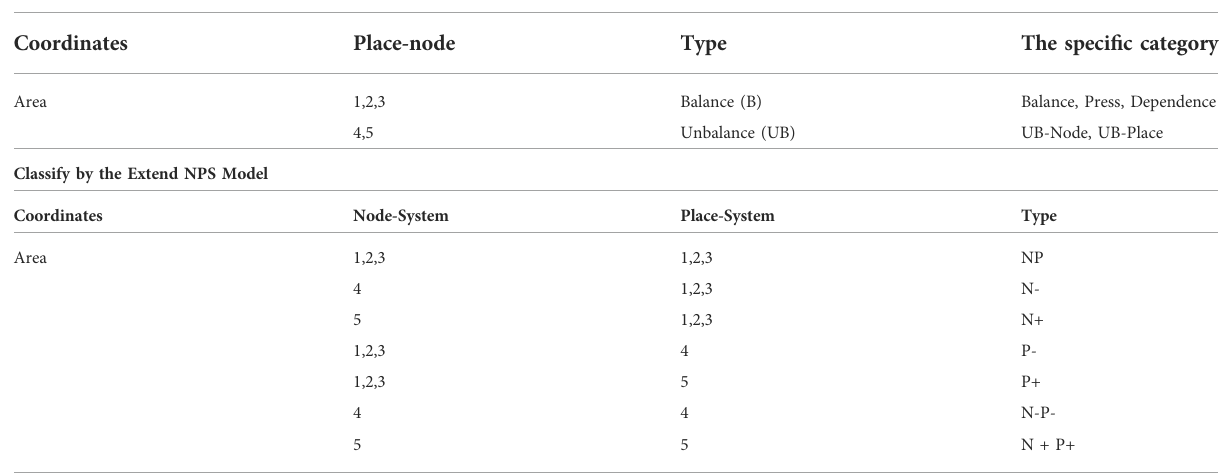
TABLE 2 Position and corresponding category in the NPS model. Classify by the NP